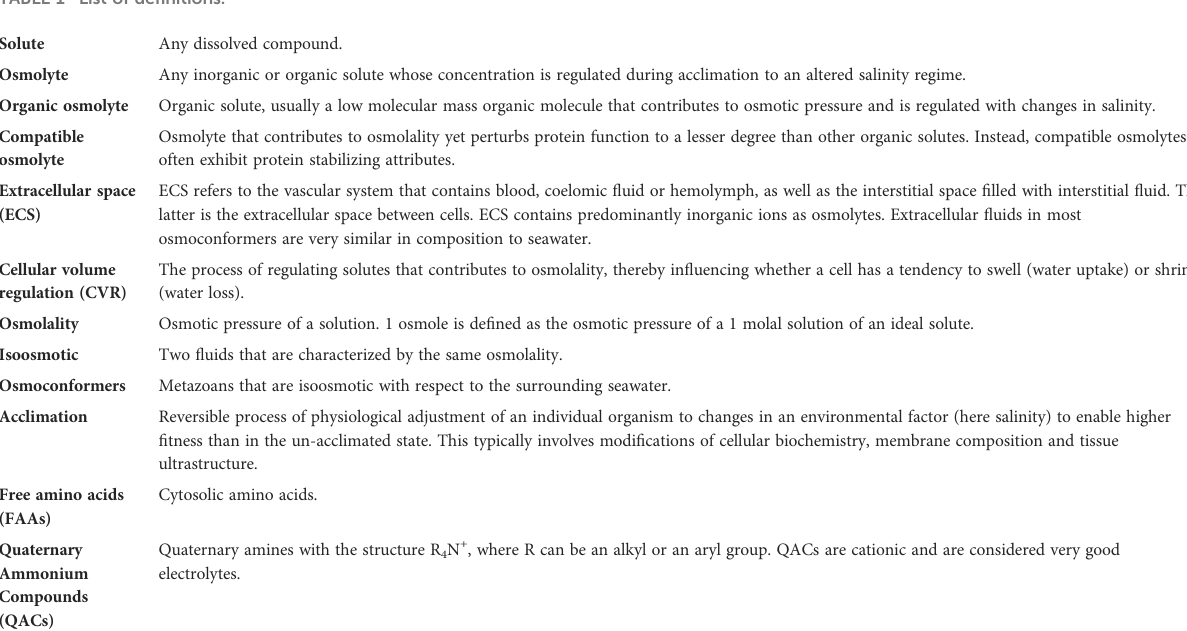
TABLE 1 List of de fi nitions.